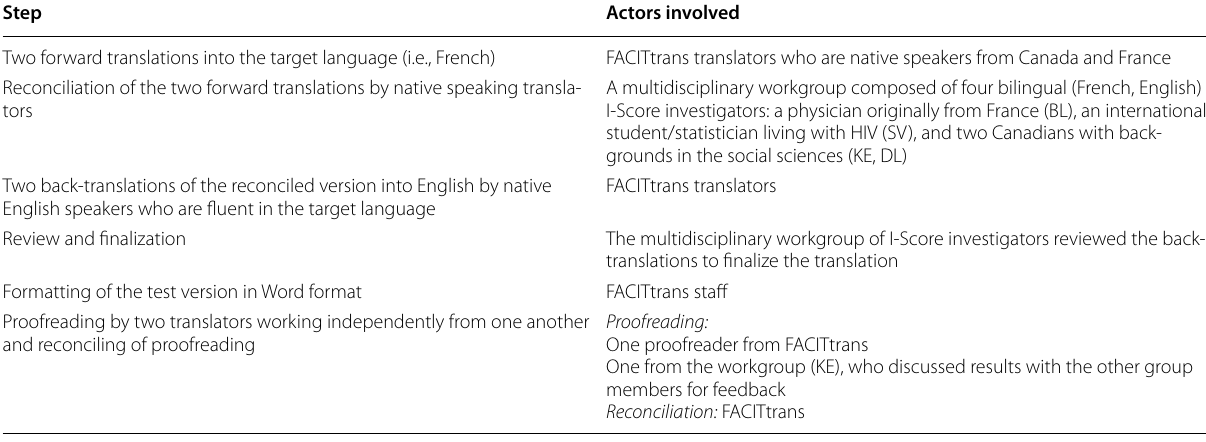
Table 1 The I-Score translation process Step Actors involved Two forward translations into the target language (i.e., French) FACITtrans translators who are native speakers from Canada and France Reconciliation of the two forward translations by native speaking transla- tors Two back-translations of the reconciled version into English by native English speakers who are fluent in the target